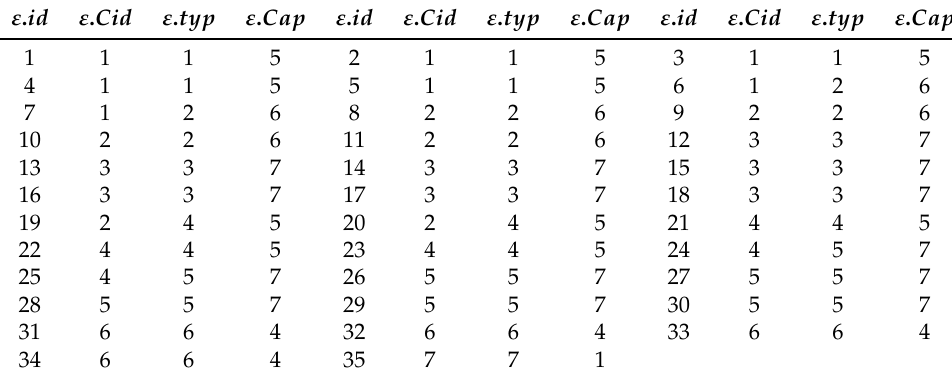
Table 3. Distribution of Resources on Six Robots.